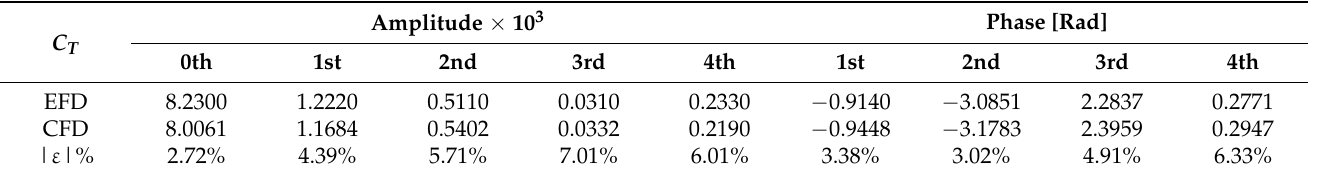
Table 20. Harmonic amplitudes and phases of surge for the FRxz ϕθ quartering waves